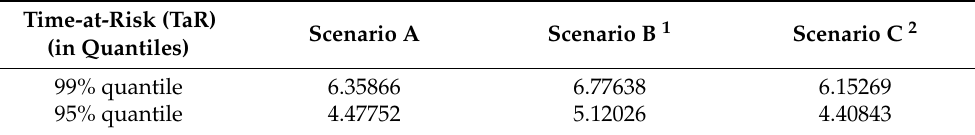
Table 4. Different scenarios reflected in time